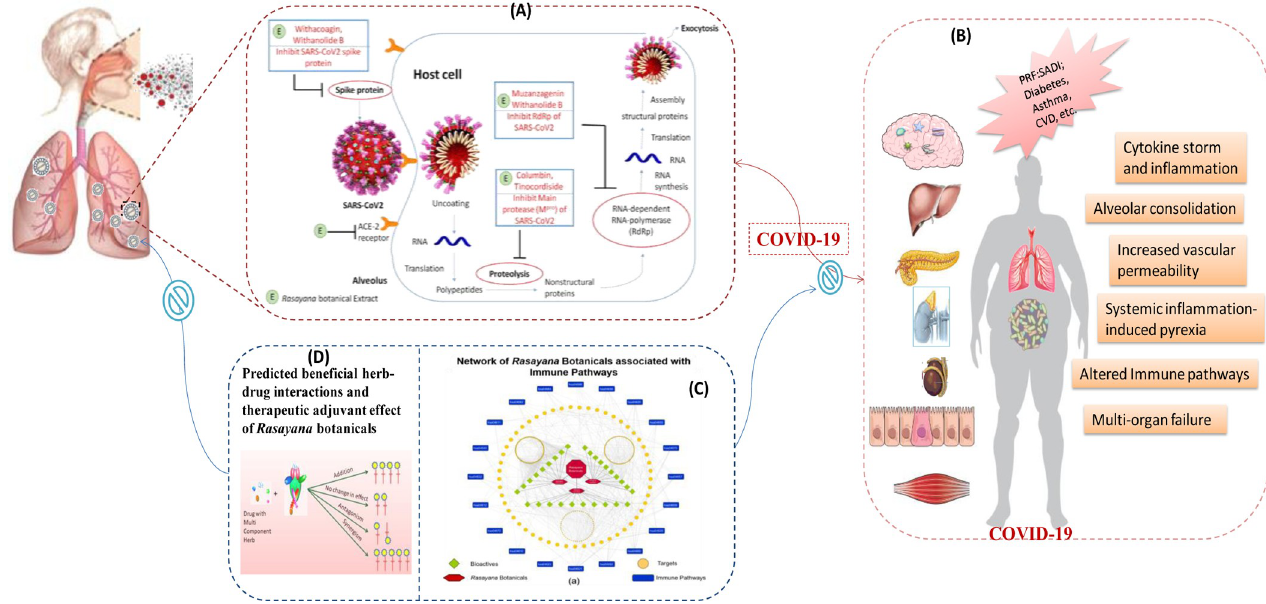
Fig 15. Predicted role of Ayurvedic Rasayana botanicals in the management of COVID-19. Once the SARS-CoV-2 virus passes the respiratory tract, it enters the lung cells with the help of its Spike protein coupled with ACE-2 receptors (these are present almost all over the body enabling its spread to multiple organs and their failure in later stages of the disease). Rasayana botanical extract constituents (E), Withacoagin and Withanolide B may inhibit COVID-19 entry by disrupting interactions between viral spike protein and host ACE-2 receptor. Rasayana botanicals may inhibit viral replication through inhibition of coronavirus main protease (M pro ) and RNA-dependent RNA-polymerase (RdRp) Part A: The M pro is can be inhibited by Columbin and Tinocordiside. RdRp can be inhibited by Muzanzagenin and Withanolide-B thereby inhibiting RNA synthesis of SARS-CoV-2. This may lead to its life cycle arrest. Part-(B): The patient related predisposition factors such as sex, age, diseases, individualization (PRF:SADI) and COVID-19 pathophysiology involved in the multiple organ failure and death. Part (C): the multi-targeted immunomodulatory and adaptogenic potential of Rasayana botanicals as predicted by network pharmacology approach. Part-(D) shows higher probability for the beneficial pharmacokinetic- pharmacodynamic herb-drug interactions 37 if co-prescribed with WHO Solidarity trial drugs and drugs for COVID-19 associated comorbidities. It is interesting to note that above mentioned phytoconstituents are predicted to have good docking score, ligand efficiency, oral bioavailability, and drug likeliness. This makes them potential molecules for rapid drug discovery and development based on multi-targeted and reverse pharmacology approach for COVID-19 management. However, these in silico predictions need in vitro–in vivo validation.